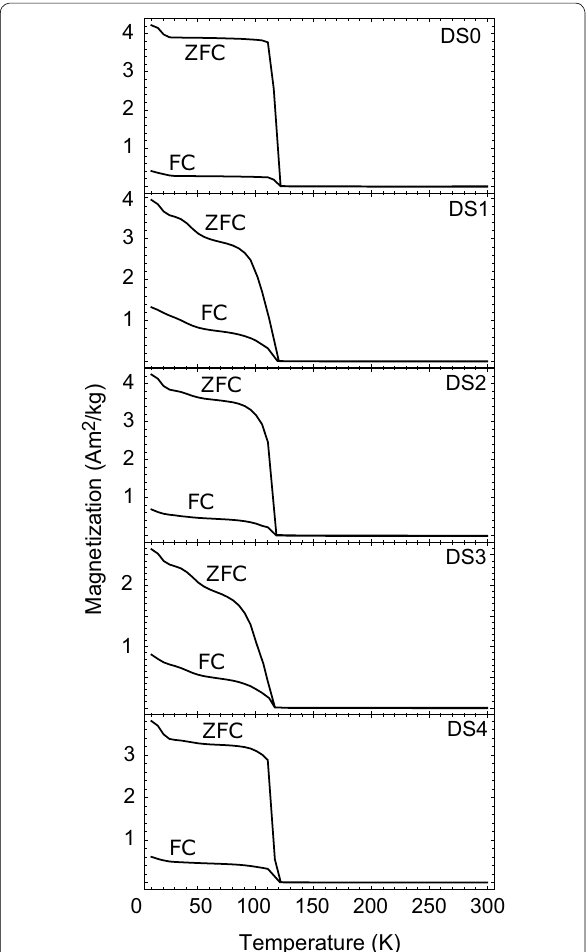
Fig. 4 Field-cooled (FC) and zero-field-cooled (ZFC) curves for all five